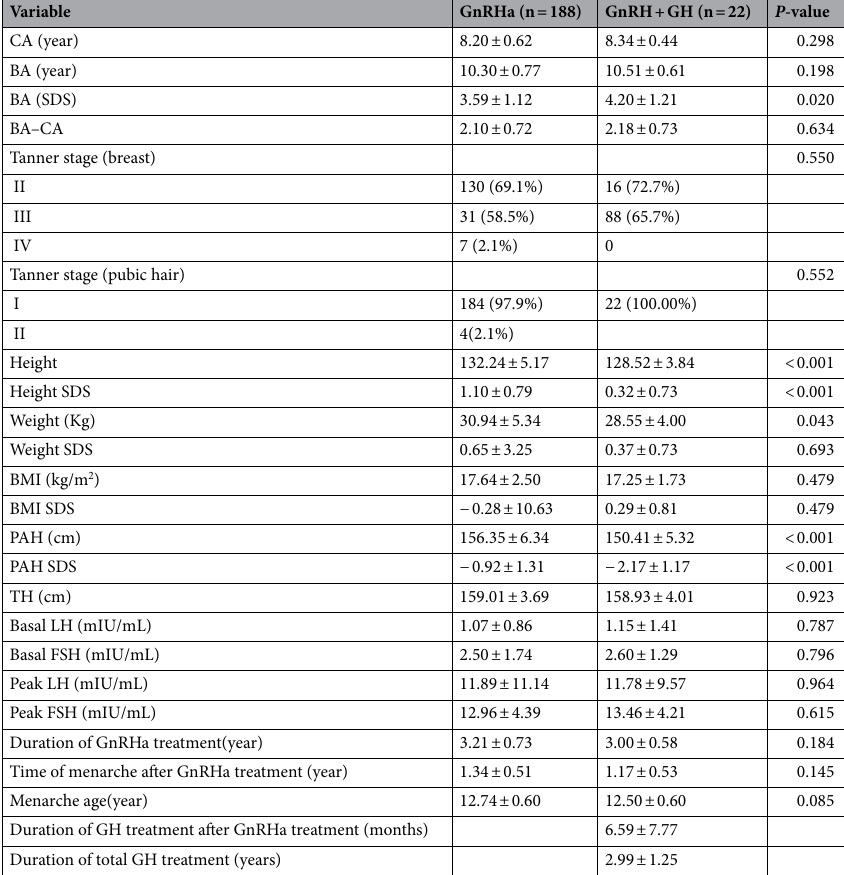
Table 1. Auxological and clinical characteristics of the patients by type of treatment. GnRHa Gonadotropin- releasing hormone agonist, GH Growth hormone, CA Chronological age, BA Bone age, SDS Standard deviation score, BMI Body mass index, PAH Predicted adult height-calculated with advanced table of baley– Pinneau(BP)method, TH Target height, LH Luthenizing hormone, FSH Follicular stimulating